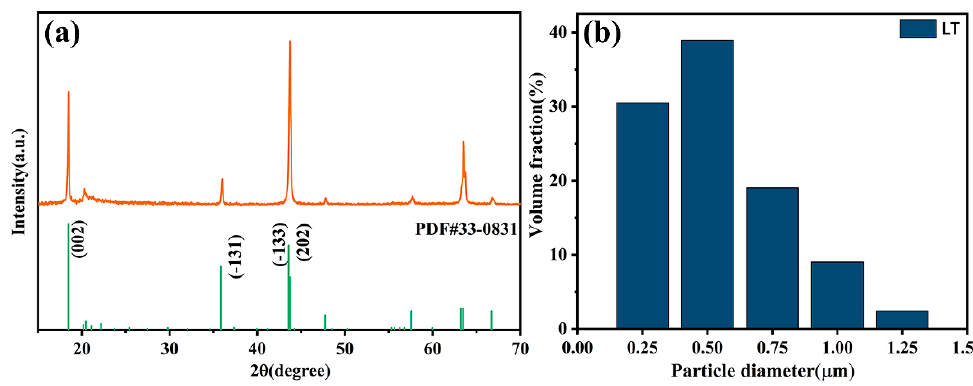
Figure 3. ( a ) XRD pattern of Li 2 TiO 3 -MgO-LiF (LT) powders; ( b ) particle diameter distribution of LT powders after ball milling.